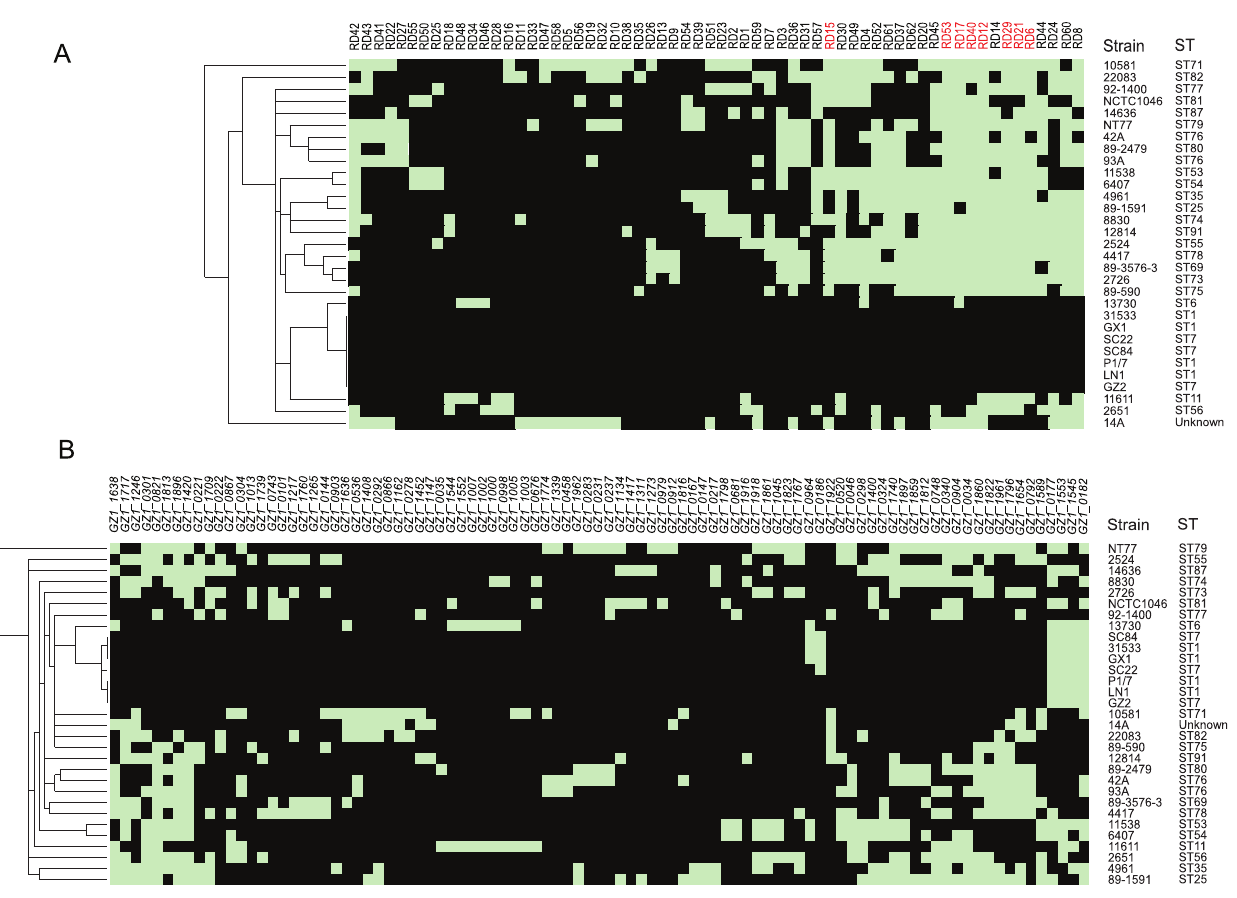
Figure 4. Clustering of variable genes and regions detected by tiling microarray of 31 S.suis strains. (A) Clustering of regions of difference (RDs) and S. suis strains based on the presence or absence of RDs in the 31 test strains. For each individual strain, the presence of a RD is represented by a black box, whereas the absence of a RD corresponds to a cyan box. The dendrogram constructed by average linkage hierarchical cluster analysis shows the relationships of the 31 strains. The strain names and sequence types are presented on the right side. RD numbers are given at the top and red text indicates high pathogenicity associated RDs. (B) Clustering based on the presence or absence of singular variable genes (SVGs). Color coding is the same as in (A).